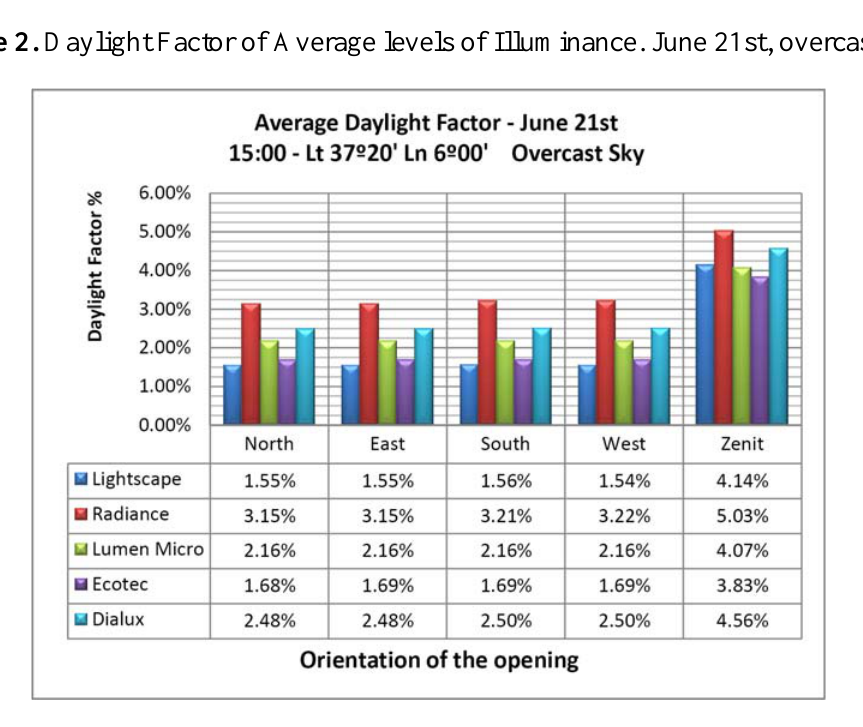
Figure 3. Daylight Factor of Maximum Illuminance Levels. June 21st, overcast